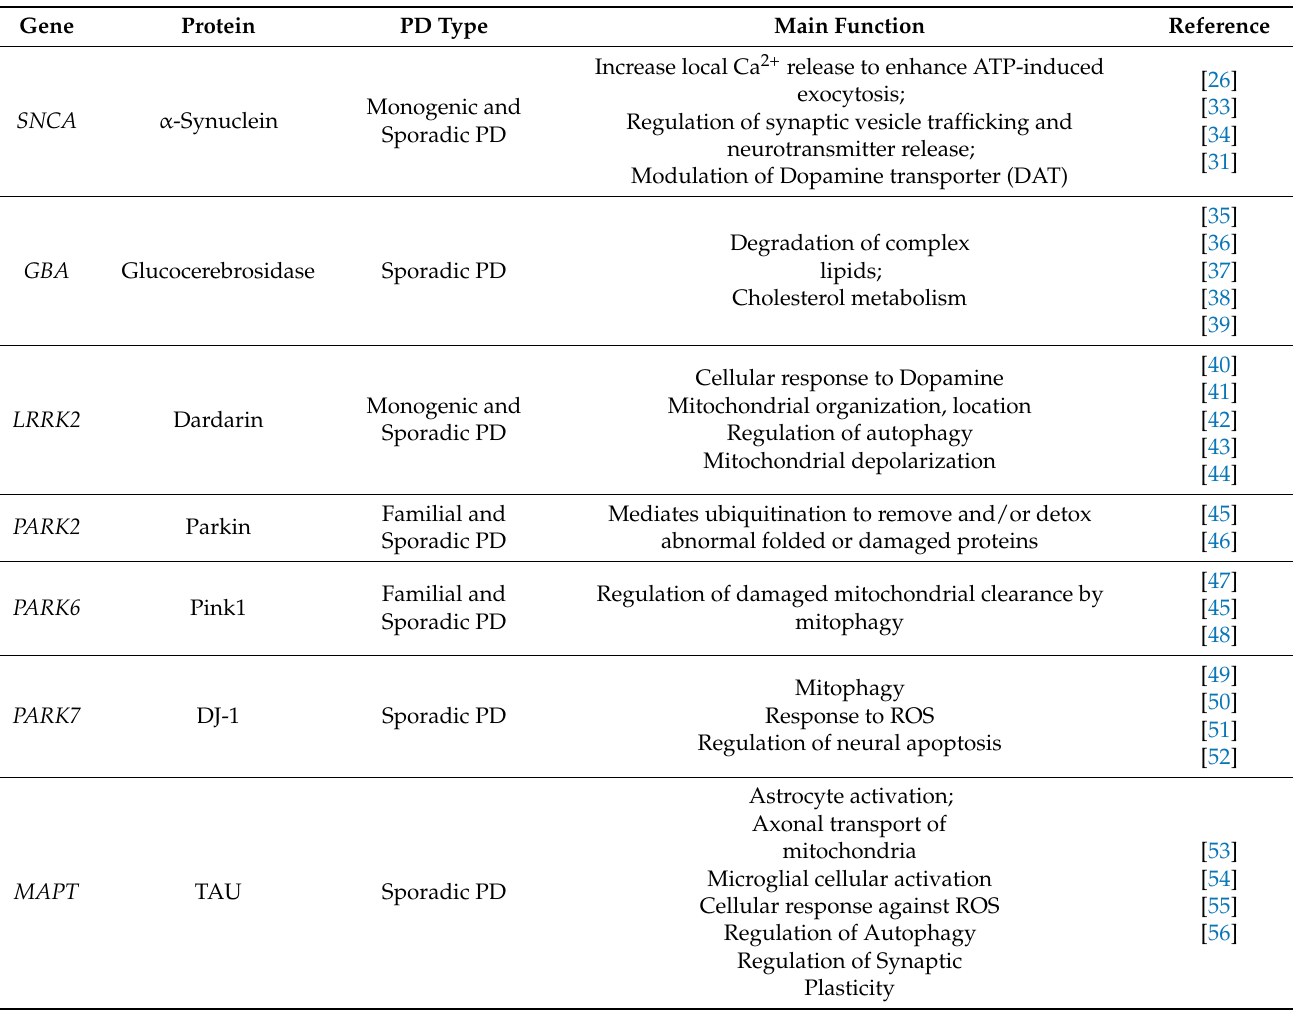
Table 1. Parkinson’s disease-associated